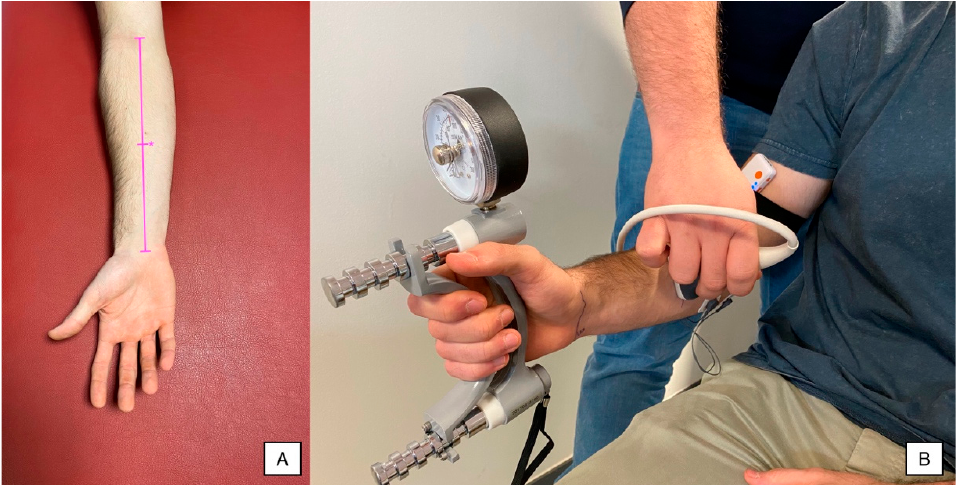
Figure 1. ( A ) Anthropometric references to identify the measurement point (*) and ( B ) EMG, US and hand dynamometry settings for simultaneous recording.